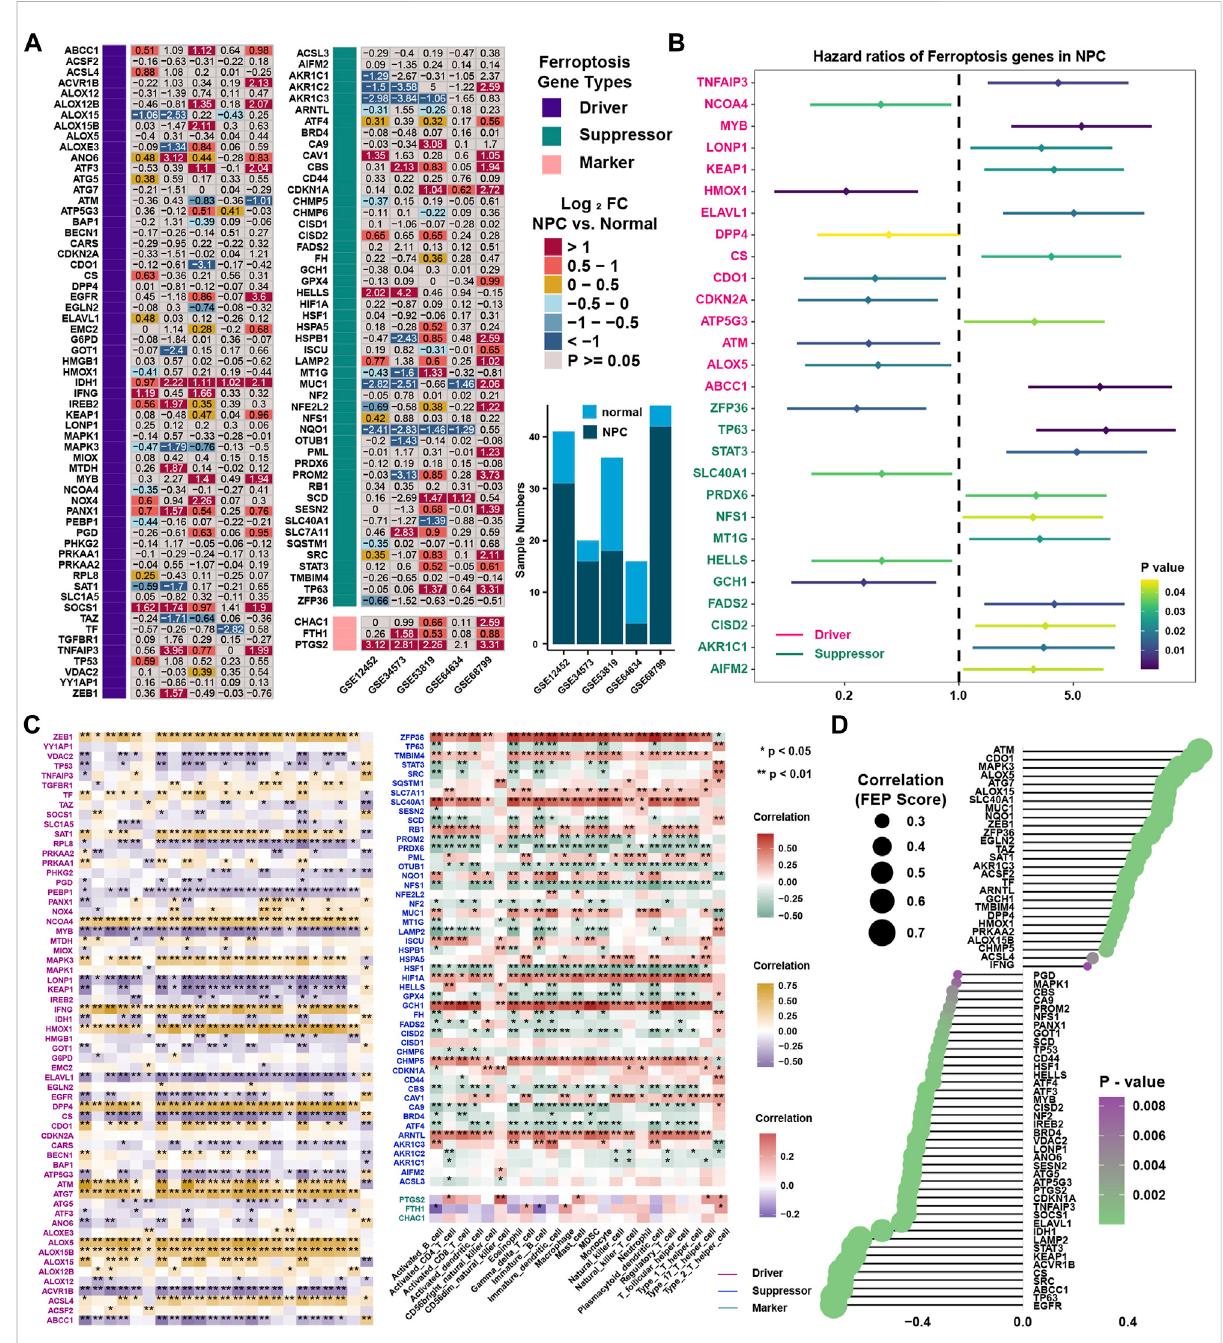
FIGURE 7 Identi fi cation of candidate ferroptosis genes. (A) Differentially expressed ferroptosis regulators in NPC samples in comparison with normal tissue in fi ve independent NPC datasets including GSE12452, GSE34573, GSE53819, GSE64634 and GSE68799 in GEO database. (B) The prognostic analyses of 113 ferroptosis regulators in GSE102349 cohorts. Hazard ratio > 1 and < 1 represented risk factor and protective factor for survival, respectively. (C) Correlation analysis between ferroptosis regulators and tumor-in fi ltrating immune cells in TME using Spearman analysis in GSE102349. (D) Correlation analysis between FEP score and ferroptosis